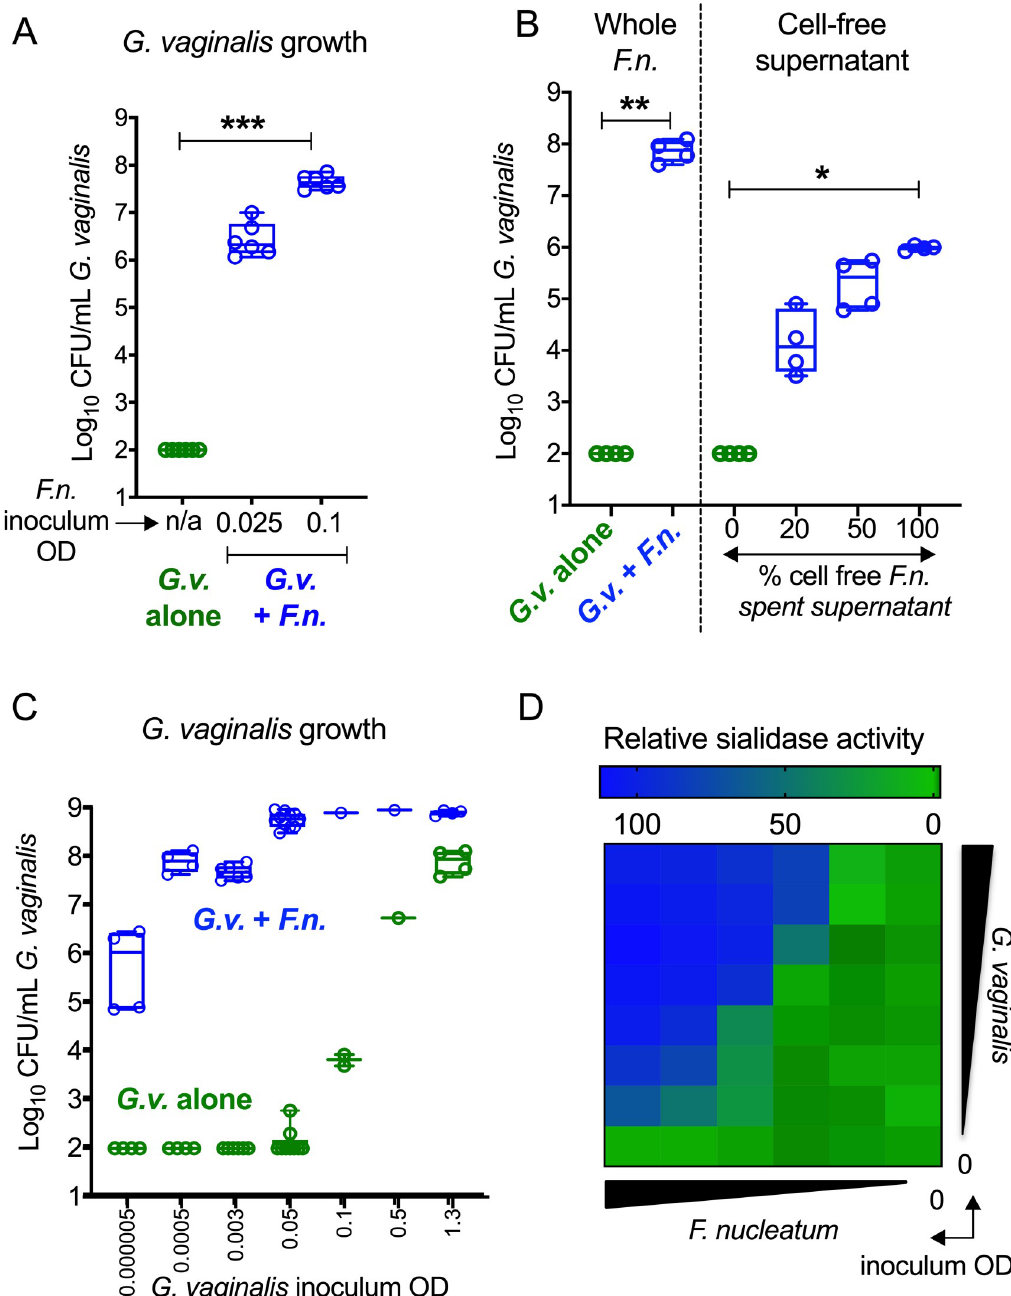
Fig 8. Enhanced growth of G . v . in cocultures with F . n . (A) Analysis of G . v . growth by CFU enumeration in anaerobic cocultures with or without F . n . in supplemented Columbia medium. Data shown are combined from 2 independent experiments, with 3 technical replicates each. (B) Growth of G . v . in media with whole F . n . or spent cell-free supernatant from F . n . culture. Data shown are combined from 2 independent experiments, with 2 technical replicates each. (C) Dose-dependent effect of F . n . on G . v . growth in supplemented Columbia medium. Data shown are combined from 9 independent experiments. Note that at low inocula, G . v . was not detectable under these conditions in the absence of F . n . In this case, G . v . levels were plotted at one-half the LOD (LOD = 200 CFU/mL). For A–C, data are represented in box plot format with whiskers of min and max. Statistical analysis: Kruskal–Wallis followed by Dunn’s multiple comparisons test. (D) Sialidase activity in G . v . cultured overnight with F . n . WT in supplemented Columbia medium. Heat map data are representative of 2 independent experiments. Inoculum range— F . n . OD 600 : 0, 0.00625, 0.0125, 0.025, 0.05, 0.1; G . v . OD 600 : 0, 0.000781, 0.001562, 0.003125, 0.00625, 0.0125, 0.025, 0.05. The underlying numerical data for this figure can be found in S1 Data. On all graphs, � P < 0.05, �� P < 0.01,